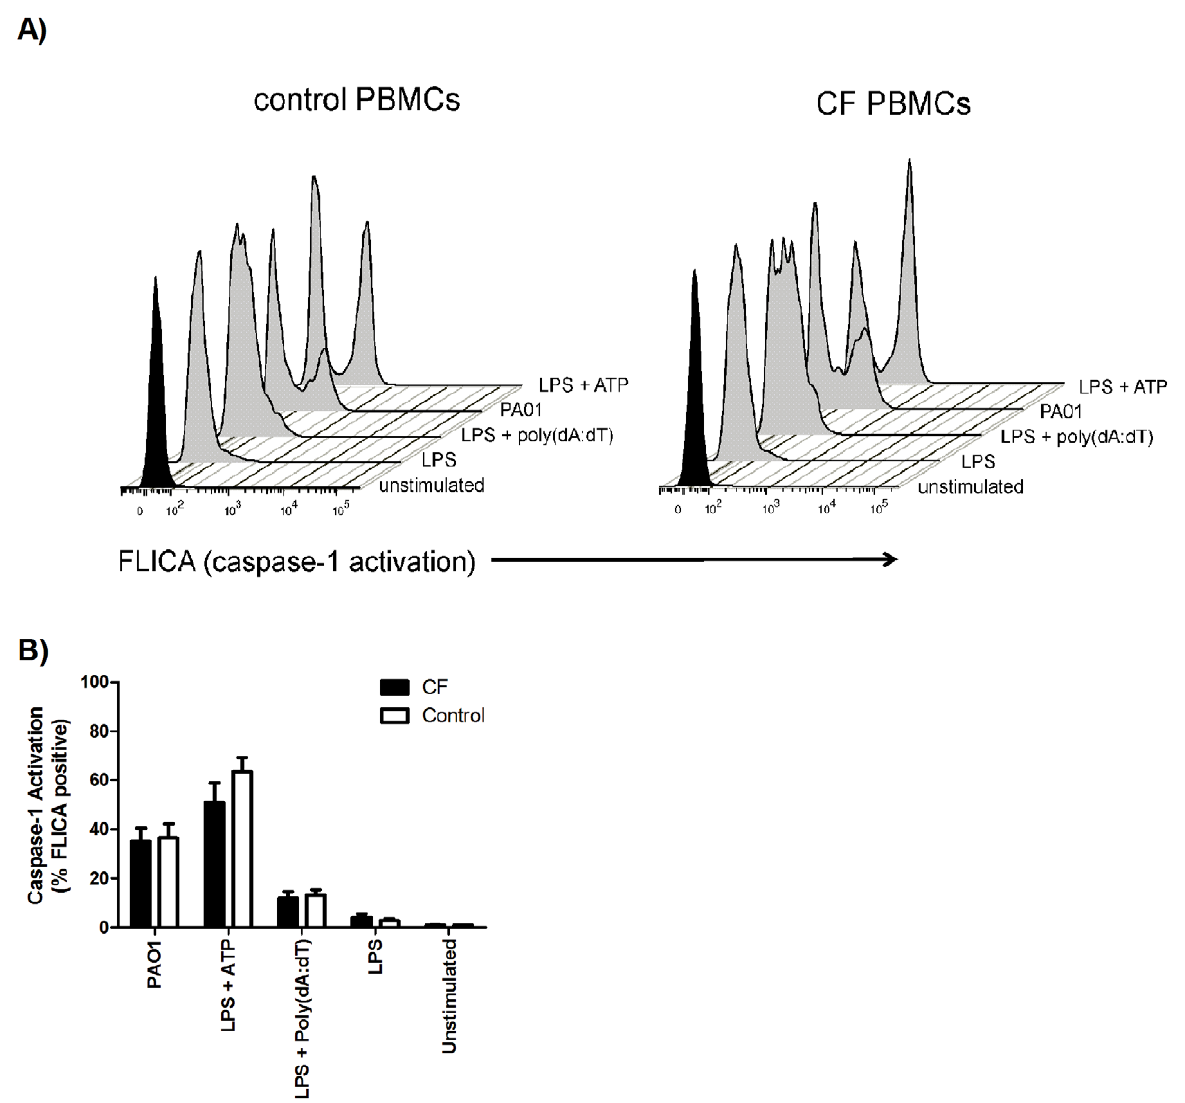
Figure 4. PBMCs from CF patients and controls show similar increases in caspase-1 activity upon inflammasome activation. PBMCs from CF patients (n=6) and healthy controls (n=6) were primed with LPS (10 ng/ml) for 5 hours prior to stimulation with ATP (5 mM) for 1 hour or Poly(dA:dT) (1 m g/ml) for 3 hours. PBMCs were stimulated with P. aeruginosa strain PAO1 for 3 hours. A representative histogram of the % caspase-1- active cells is shown in (A) with the averaged values shown in